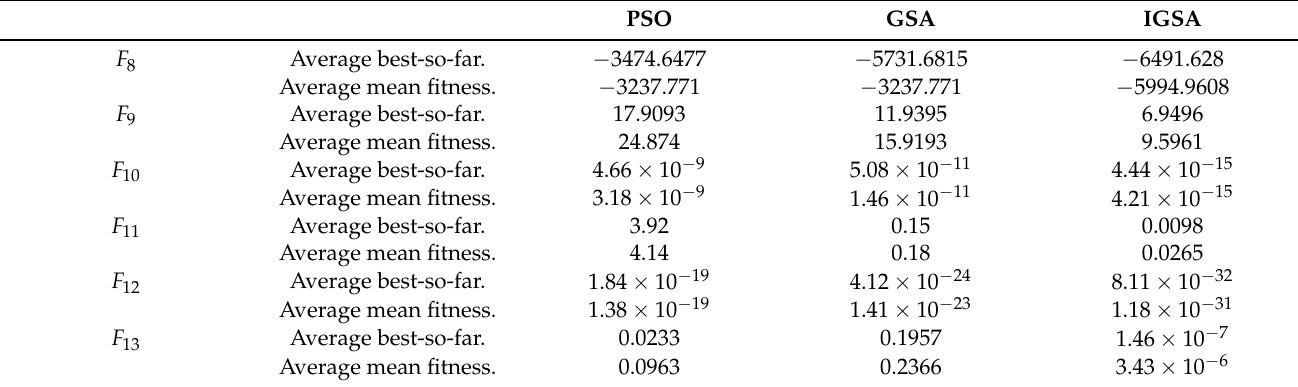
Table 4. Experimental results of multimodal functions.